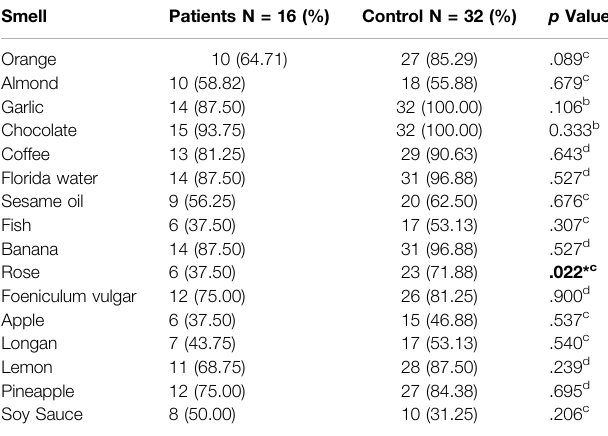
TABLE 6 | Detailed information of Chinese Smell Identi fi cation Test in ALMS patients and controls. Smell